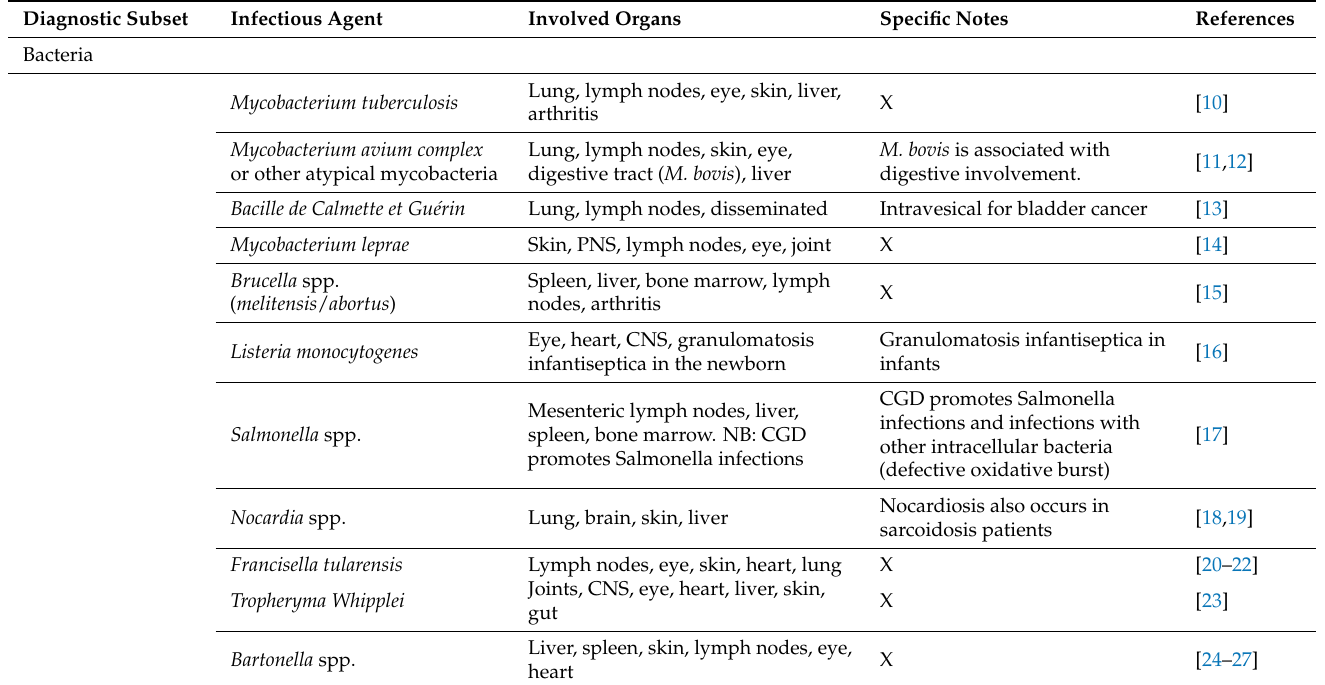
Table 1. Infectious differential diagnosis of sarcoidosis and their main organ involvement. Diagnostic